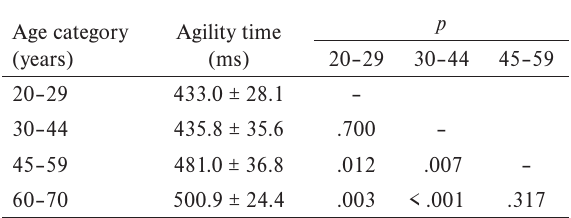
Agility time (mean ± SD) and interdifference matrix between agility times of table tennis players of different ages